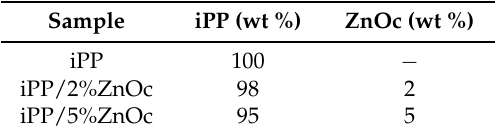
Table 1. Isotactic polypropylene/Zinc oxide coated with stearic acid (iPP/ZnOc)